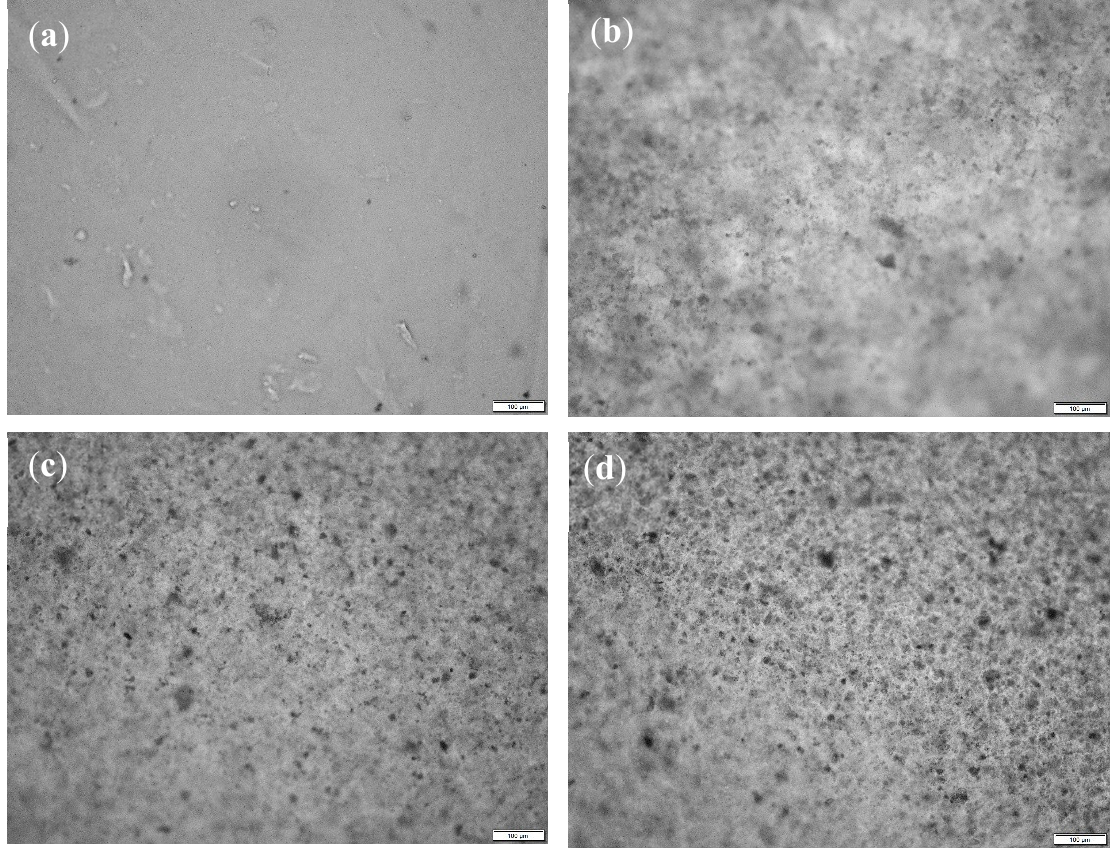
Figure 6. ( a ) Contact angles of droplets on agar/zeolite/CMC/PVA biomembrane and ( b ) swelling ratio with different time intervals of biomembrane based on agar/zeolite/CMC/PVA.